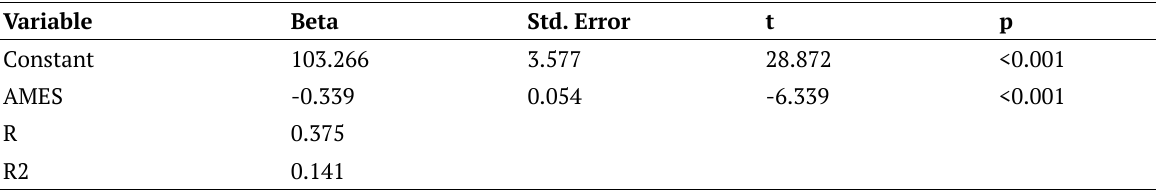
Table 5. Simple Linear Regression Analysis (Model 2)